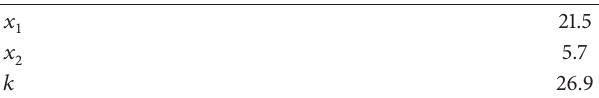
Table 2: Best values for 𝑘 , 𝑥 1 , 𝑥 2